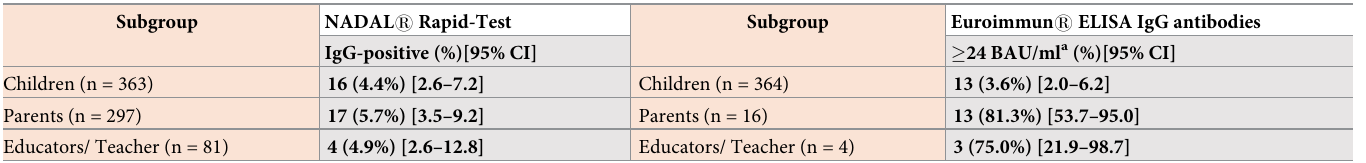
Table 2. IgG antibodies in parents and educators/ teachers at baseline.